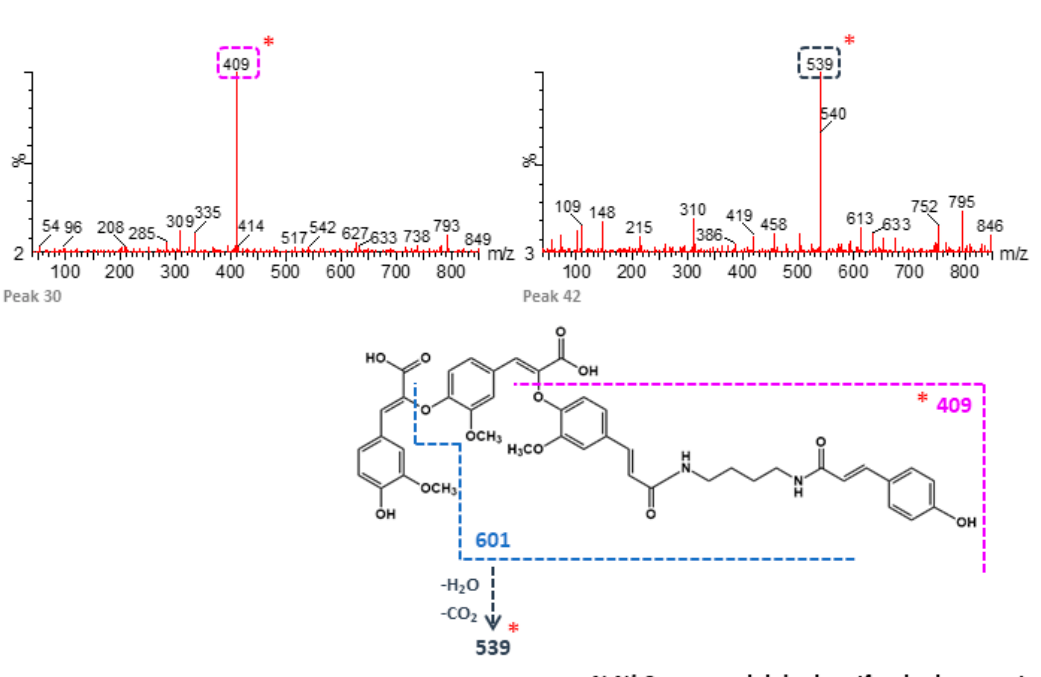
Figure 5. Fragmentation patterns proposed for dehydrotriferuloyl (8-O-4 ′ /4-O-8 ′ ’-TFA) putrescines. * : Characteristic product ions of C-O linkages between feruloyl moieties. Ұ : Product ions formed after amine protonation.